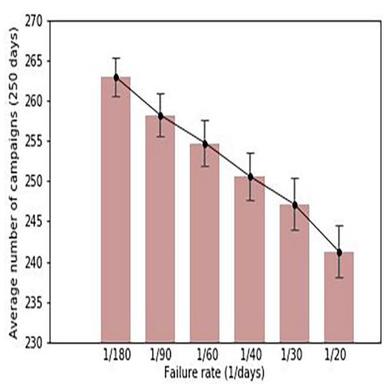
2. With the failure rate parameter of 1/180 days, the average number of campaigns is 263 ± 2.4. The following average numbers of campaigns given the failure rate parameters of 1/90 days, 1/60 days, 1/40 days, 1/30 days, and 1/20 days are 258 ± 2.7, 255 ± 2.8, 251 ± 2.9, 247 ± 3.2, and 241 ± 3.2.